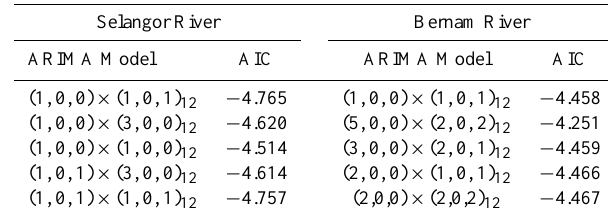
Table 1. Comparison of ARIMA models’ Statistical Results for Selangor and Bernam